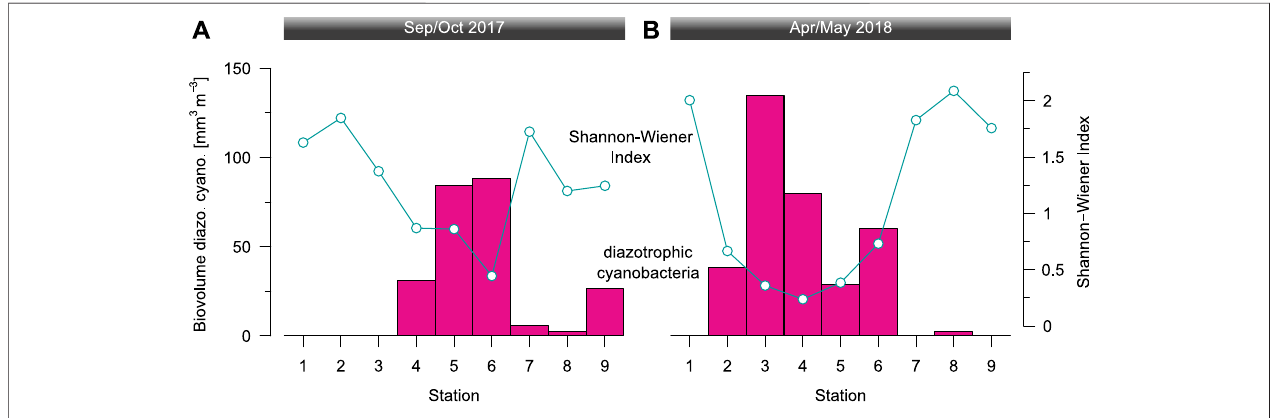
FIGURE 7 | The average biovolume of fi lamentous, diazotrophic cyanobacteria in the top 25 m and Shannon-Wiener diversity index of the depth-integrated phytoplankton community ( > 10 µm) during (A) the end of the dry season (September/October 2017) and (B) the end of the rainy season (April/May 2018).